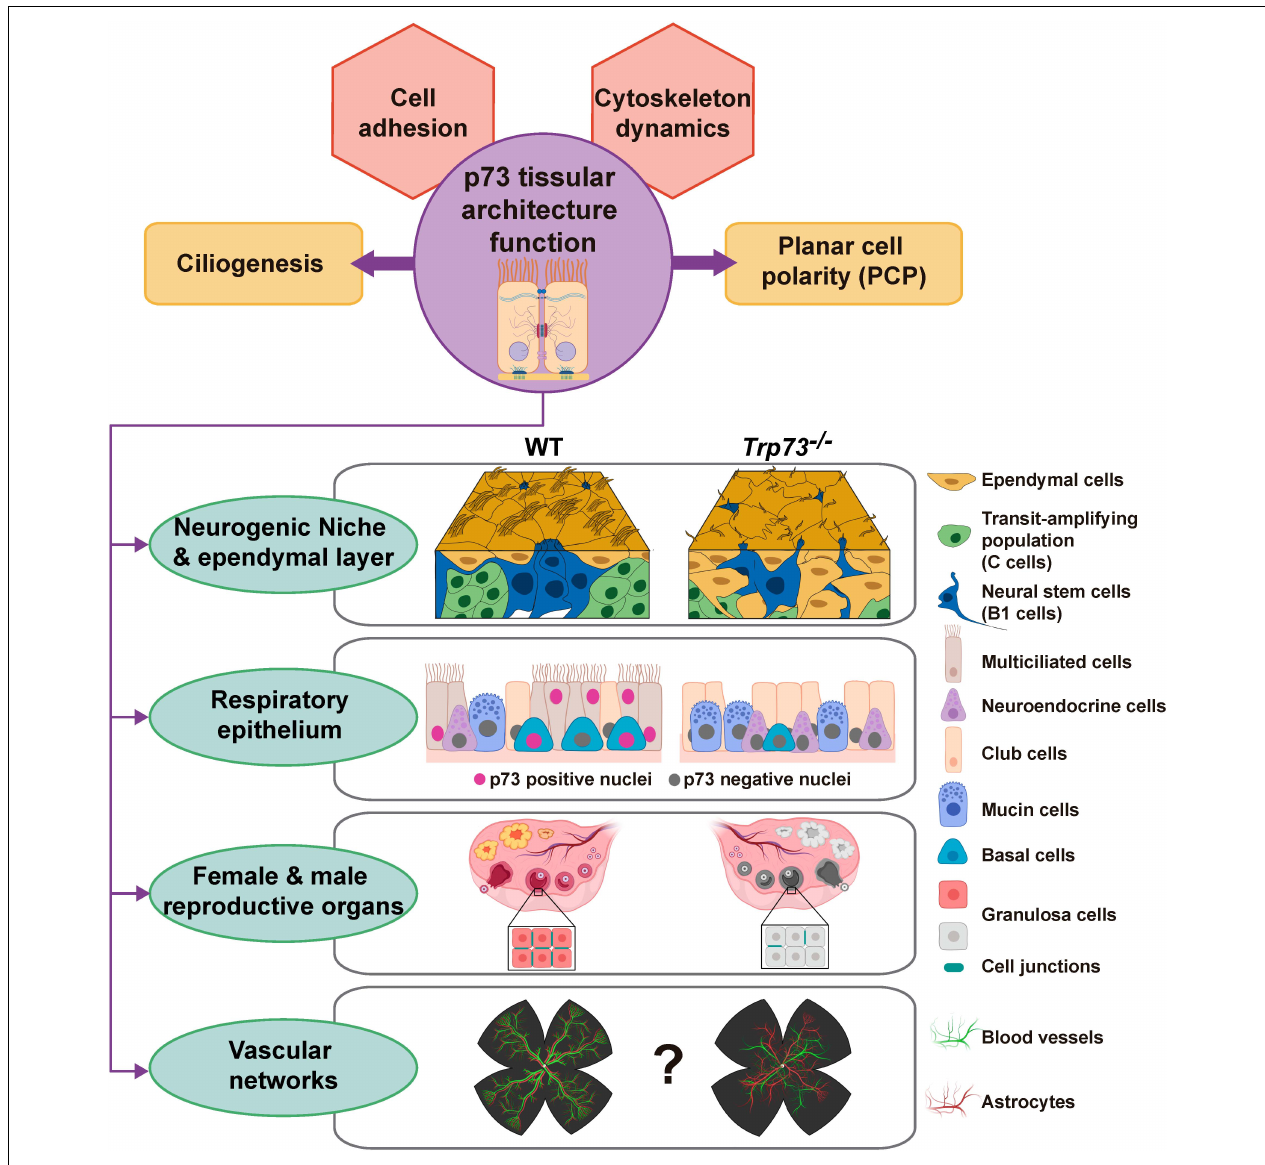
FIGURE 4 | Overview of the proposed p73 novel role as a tissue architect. We present a model in which p73 would act as a tissue architect by regulating transcriptional hubs involved in cellular adhesion and cytoskeleton dynamics. In determined spatio-temporal contexts, TAp73 will interplay with other transcriptional programs to orchestrate morphogenic processes like ciliogenesis and/or PCP, ensuring the correct overall tissular architecture in complex microenvironments such as neurogenic niche, the respiratory and reproductive epithelium and, maybe, the vascular network. The pictures were created with